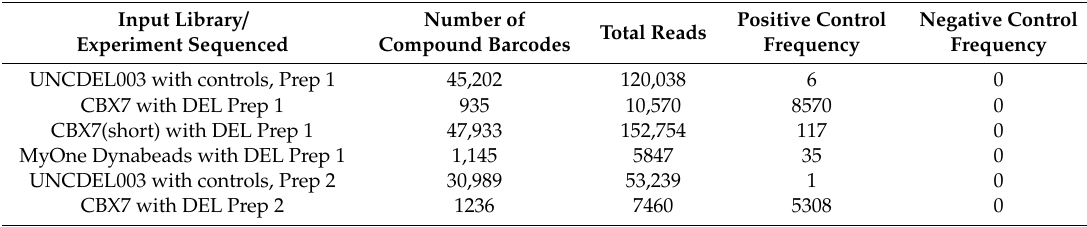
Table 2. Sequencing results from experiments containing control